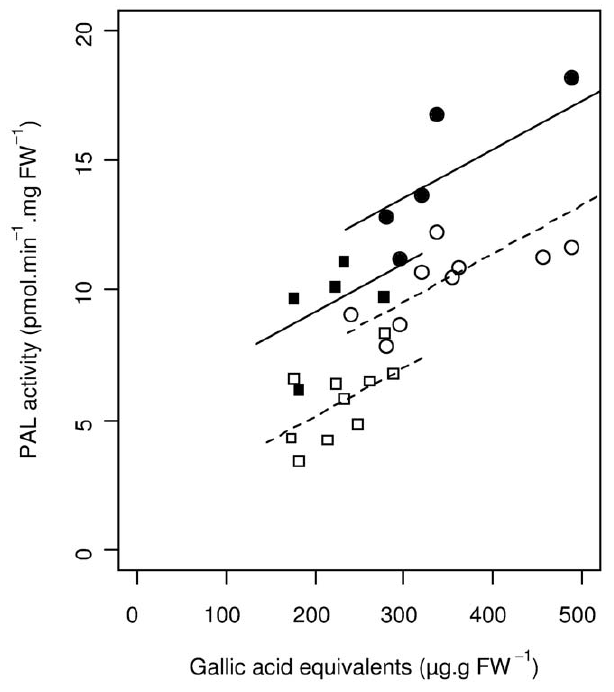
Figure 5. Relation between Phenylalanine ammonia-lyase activity and total phenolic content. Phenylalanine ammonia-lyase (PAL) activity and total phenolic content (expressed as gallic acid equivalents) were measured in extracts from potato tuber tissue treated with water (Control), a concentrated culture filtrate (CCF) from Phytophthora infestans or purified lipopolysaccharides (LPS) from Pectobacterium atrosepticum . By cultivar means of water and LPS treated samples are represented as white symbols, CCF treated samples as black symbols. Experiments were performed on 5 potato cultivars (Ackersegen, BF15, Bintje, Kerpondy, Saturna) from tuber batches produced in 2009 and used for experiments after 2 months of storage (circles) and after 10 months of storage (boxes). Lines were drawn by using coefficients of a linear model fitted to by-cultivar means for PAL activity and total phenolic content.